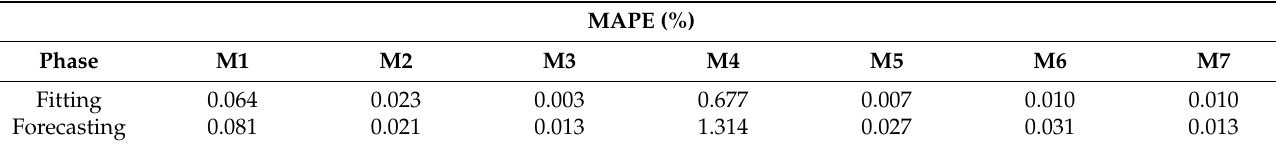
Table 30. Marker position